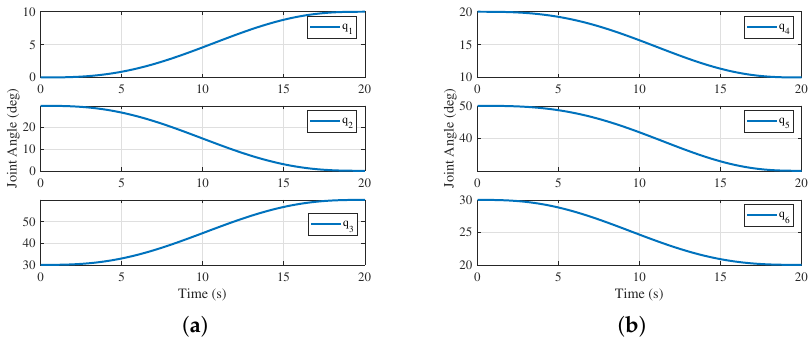
Figure 7. Angular variation curves of i th joint, where ( a ) i = 1, 2, 3, and ( b ) i = 4, 5, 6.